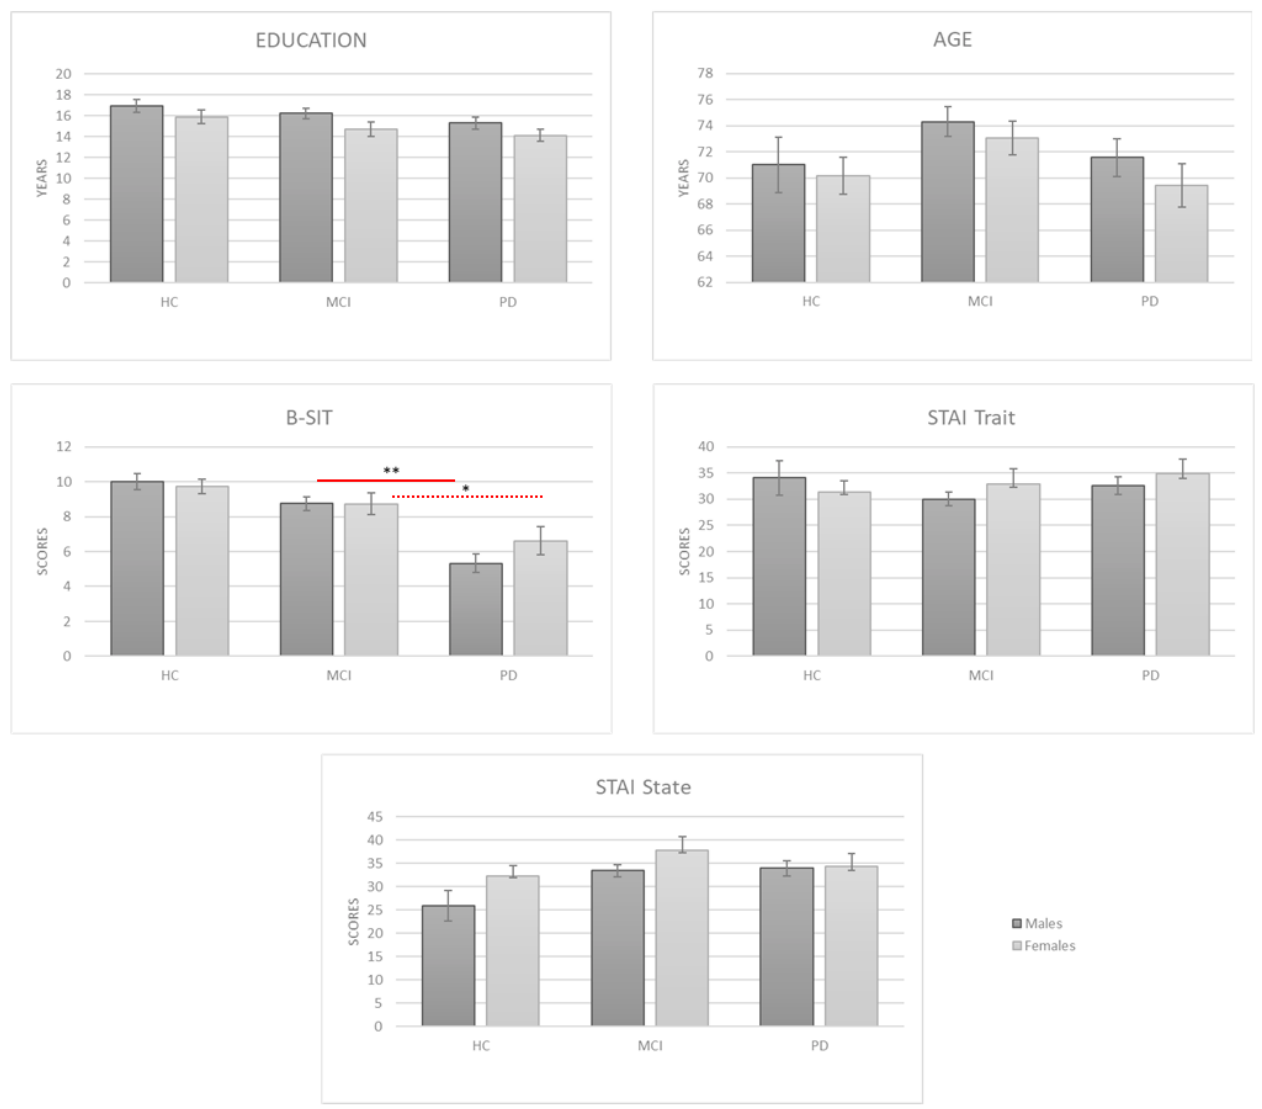
Figure 2. Error bars denote the standard errors and the * = p > 0.05 and ** = p < 0.001.